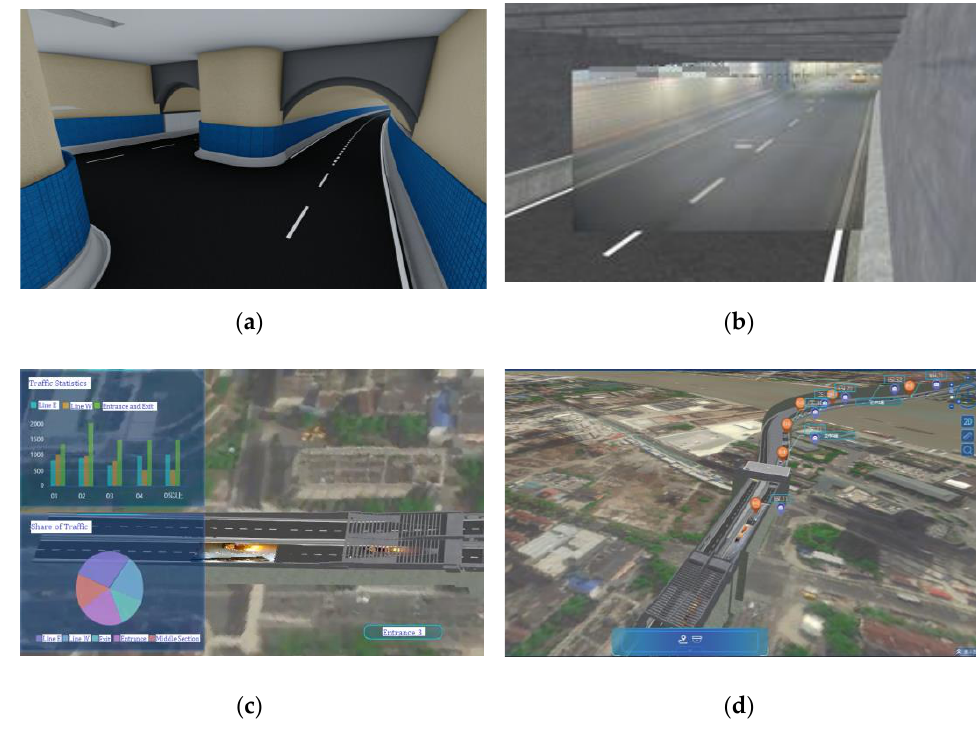
Figure 10. Schematic of the tunnel digital twin demonstration implementation process: ( a ) Demonstration scene BIM modeling; ( b ) multi-channel video real-time fusion; ( c ) IoT sensor data aggregation and fusion; ( d ) digital twin scene construction.